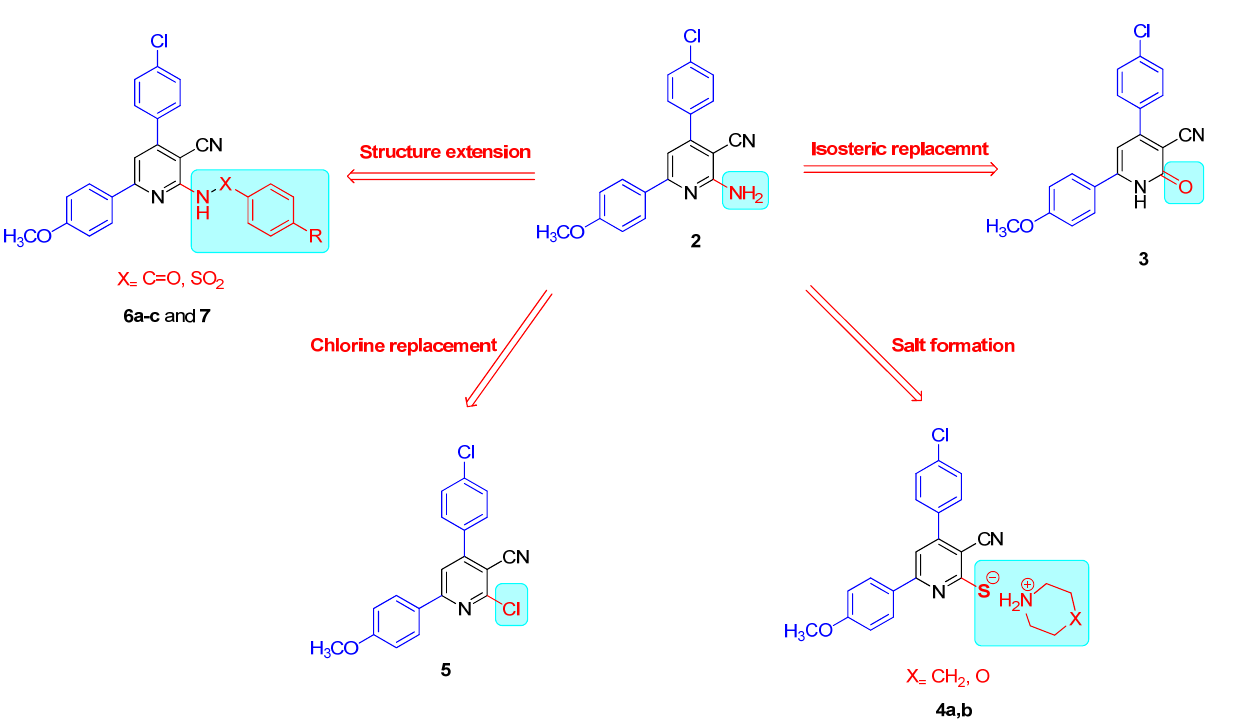
Figure 2. Design strategy of the prepared nicotinonitrile molecules 2 – 7 .